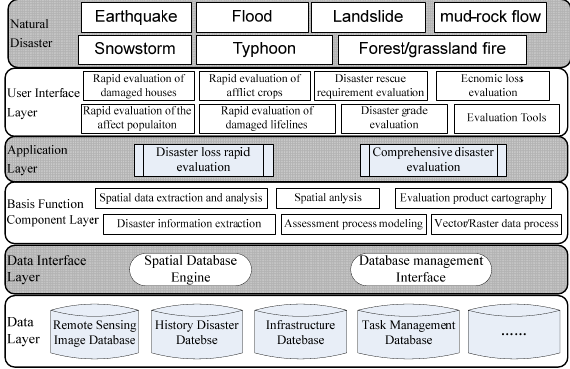
Figure 2: The general architecture and composition of disaster assessment system